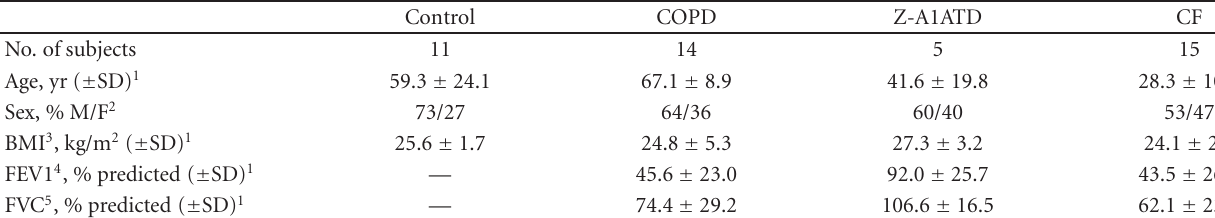
Table 1: Patient characteristics.